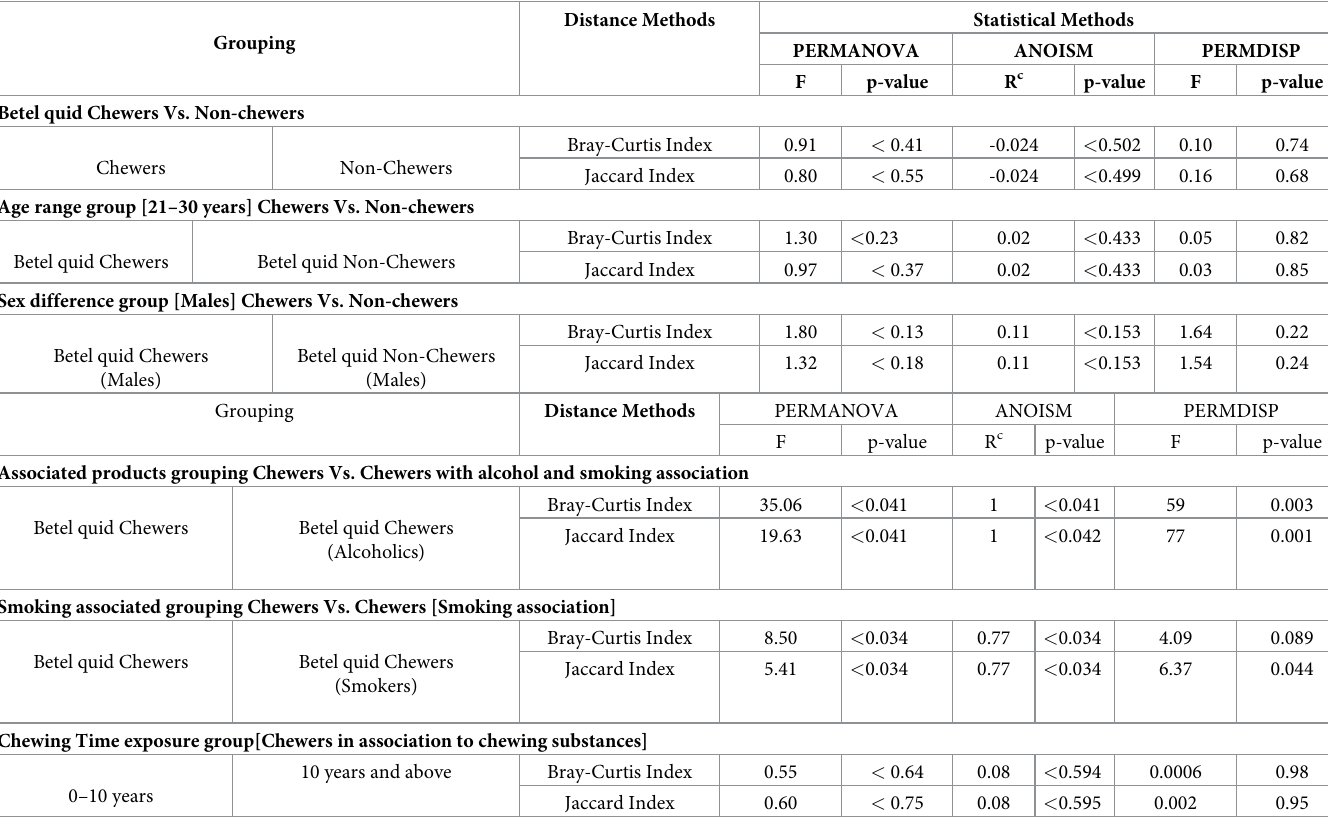
Table 4. (a) Comparison of in between groups (beta) bacterial diversity based on the study population. (b) Comparison of in between groups (beta) bacterial diversity for the study population. Grouping